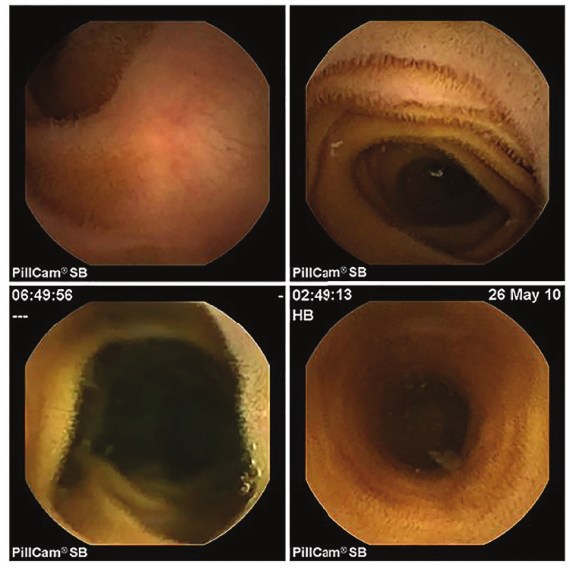
Figure 2: Several normal WCE